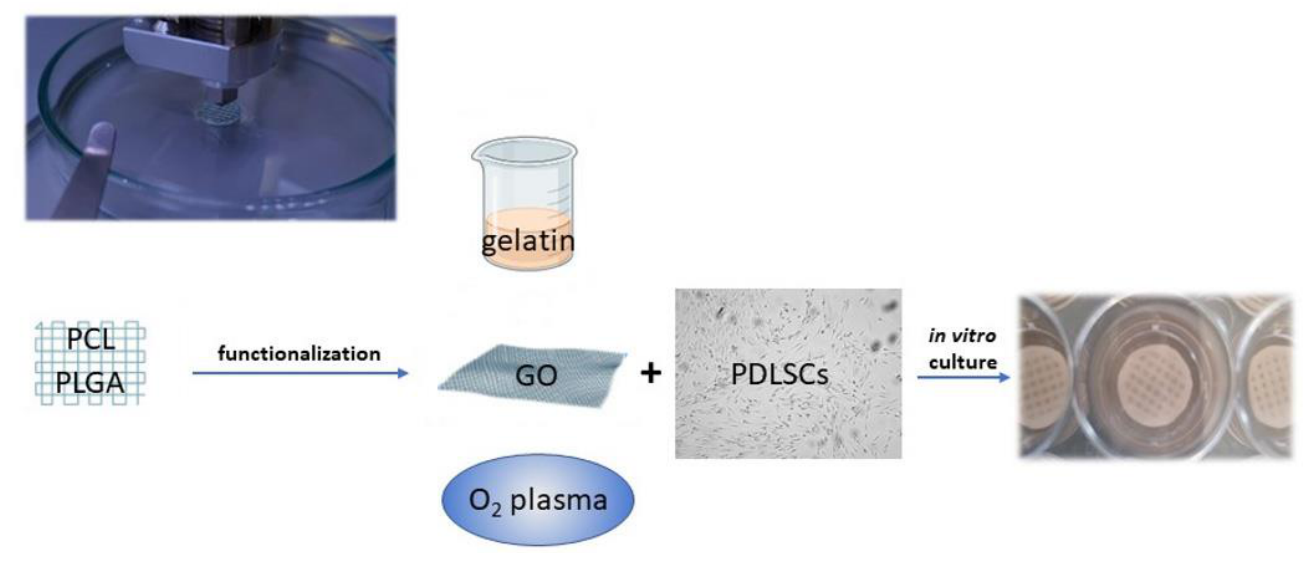
Figure 3. Polymers, such as PCL and PGLA, can be used to print scaffolds functionalized to promote PDLSC adhesion and proliferation. Different strategies of functionalization can be adopted: gelatin nanocellulose can be mixed with PCL or used as an envelope to incorporate other nanoparticles; graphene oxyde (GO) coating increases the hydrophilicity of the PCL surface; oxygen plasma variates the surface roughness.